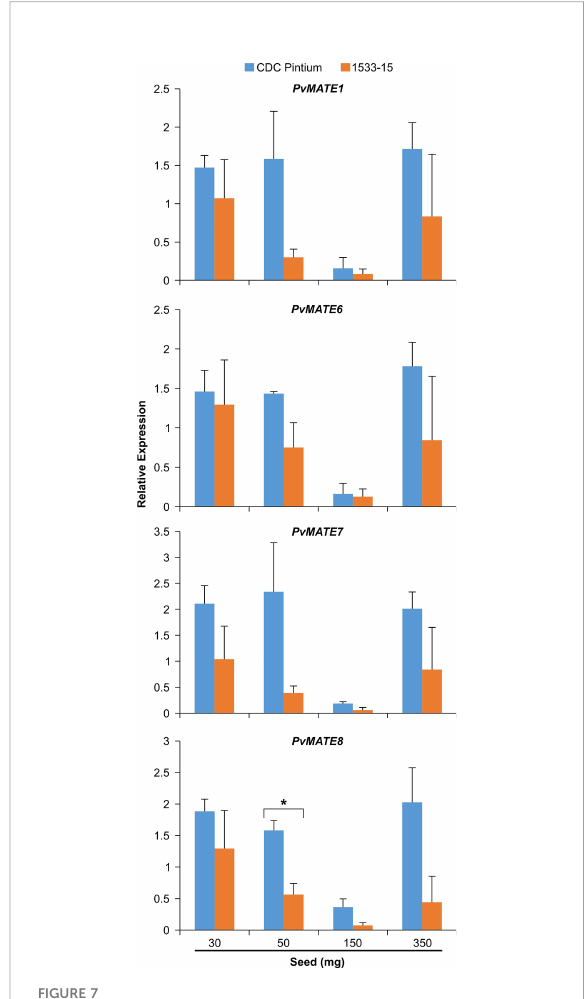
FIGURE 7 Differential expression offour selected PvMATE candidates for PA- speci fi c function. Total RNA extracted from four different stages (30, 50, 150, and 350 mg seed weight) seed coat, collected from CDC Pintium (RD) and 1533 – 15 (SD) cultivars and qRT-PCR analysis was performed using gene-speci fi c primers. Relative expression corresponds to the mean value in two biological replicates and three technical replicates per biological replicate. Error bar indicates SEM. Asterisk (*) indicates signi fi cant difference between the samples as determined by Student ’ s t